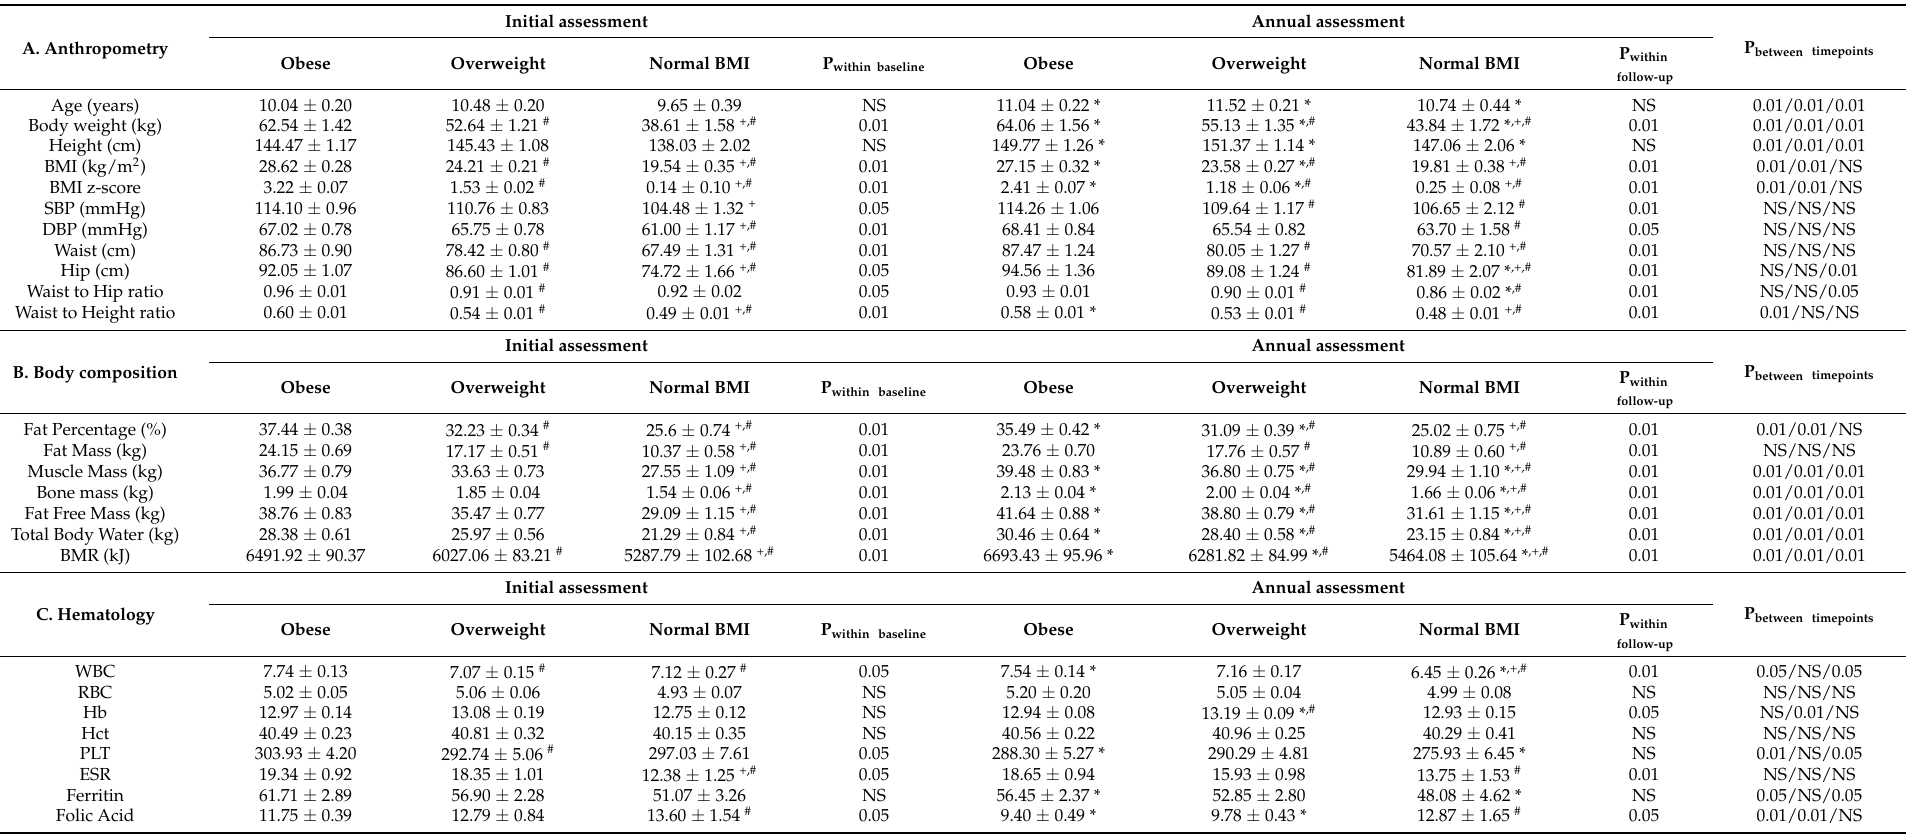
Table 1. Clinical characteristics and anthropometric parameters (1A), body composition parameters (1B), hematology (1C), biochemistry (1D), cardiometabolic (CVD) risk factors (1E), hormonal (1F) and leucocyte telomere length (LTL) (1G) measurements in all subjects with “good compliance” ( n = 407) at initial and annual